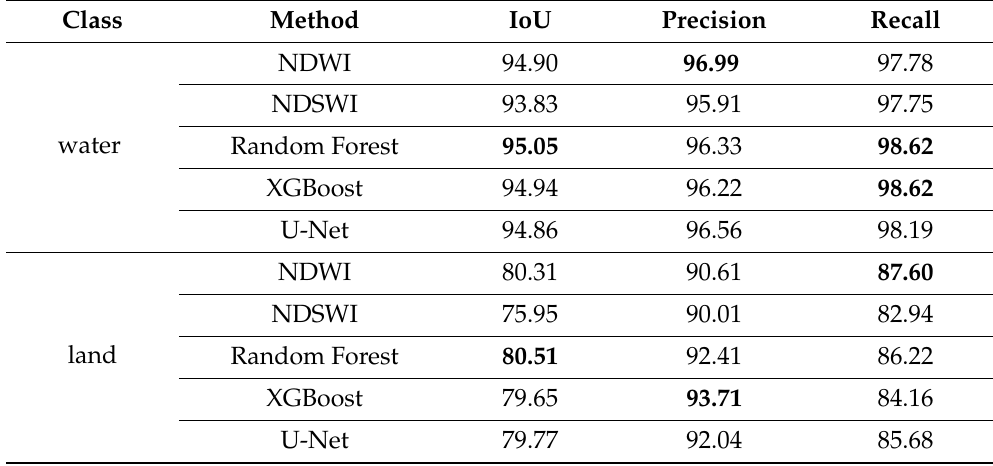
Table 2. Experimental results for binary segmentation masks generated using different methods. The IoU when using random forest is higher than when using all other methods for both land and water classes.